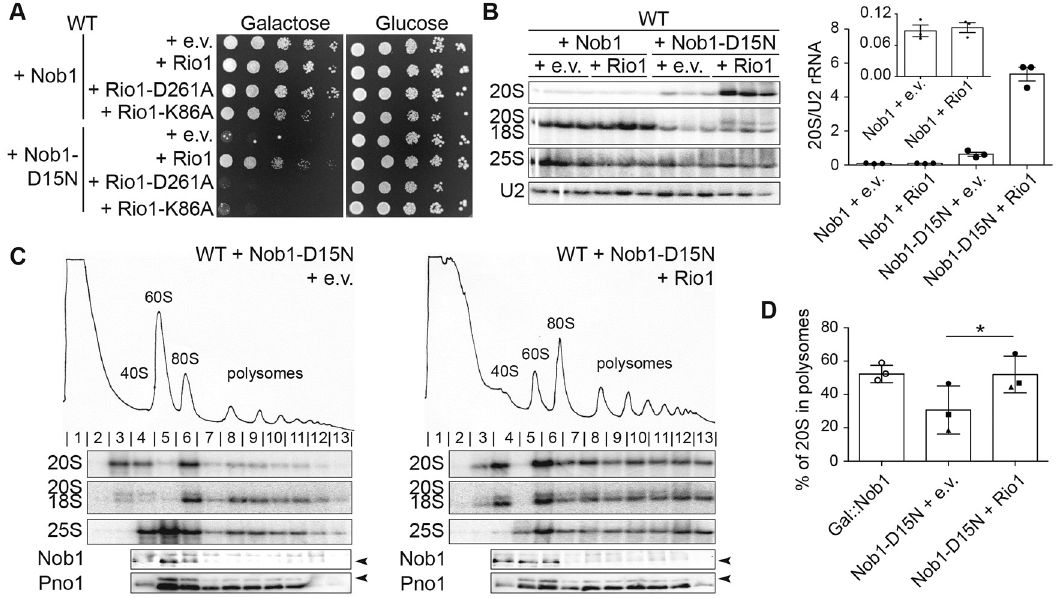
Fig 3. Rio1 releases 40S ribosomes into the translating pool. (A) Growth of cells containing an e.v. or WT Rio1, Rio1-D261A, or Rio1-K86A under a copper-inducible (Cup1) promoter and Nob1 or Nob1-D15N under the Gal promoter were compared by 10-fold serial dilutions on glucose or galactose dropout plates with 100 μ M CuSO 4 . (B) Left: northern blot analyses of total cellular RNA from cells in panel A grown in galactose with 100 μ M CuSO 4 for 16 h. Right: quantification of the northern blot. The 20S pre- rRNA levels were normalized to U2 snRNA. (C) Shown are 10%–50% sucrose gradients from cell lysates of cells in panel B. Northern blots of 20S, 18S, and 25S rRNA and western blots probing for Nob1 and Pno1 are shown below the absorbance profile at 254 nm. Arrowheads note the bands corresponding to Nob1 (lower band) and Pno1 (upper band). (D) Quantification of the gradient northern blots in (C) and in Fig 1A. Percentage of 20S pre-rRNA in polysomes (fractions 8–13) compared with total 20S pre-rRNA was calculated. Data are the average of three biological replicates, and error bars indicate SEM. Samples grown and analyzed on the same day were considered paired replicates, as indicated by the circle, square, and triangle dots on the graph. Paired t test was used for statistical analysis; � p = 0.0123. See also S1, S2 and S3 Figs. Numerical data are listed in S1 Data. e.v., empty vector; Gal, galactose; snRNA, small nuclear RNA; WT,